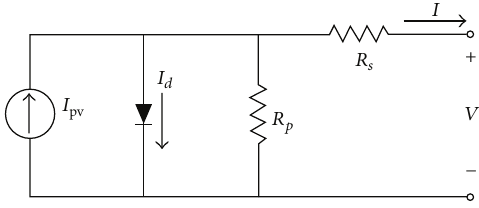
Figure 1: The equivalent circuit of the SDM.